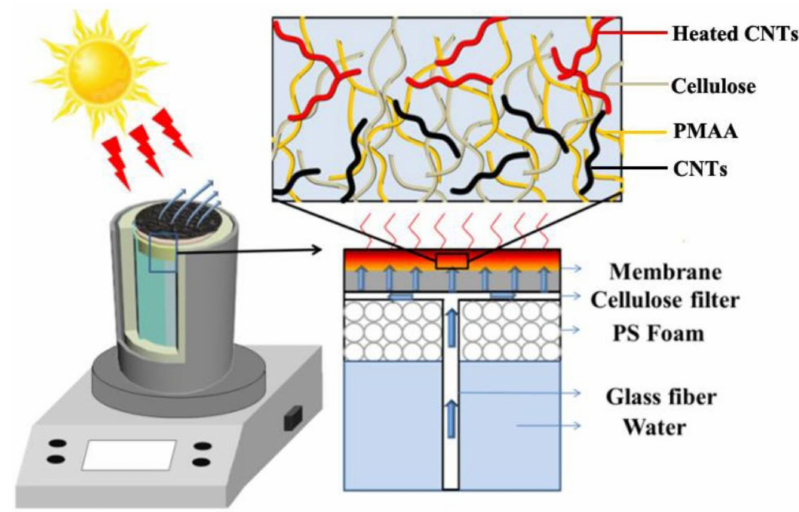
Figure 6. Schematic diagram of the transporter-assisted evaporation system.